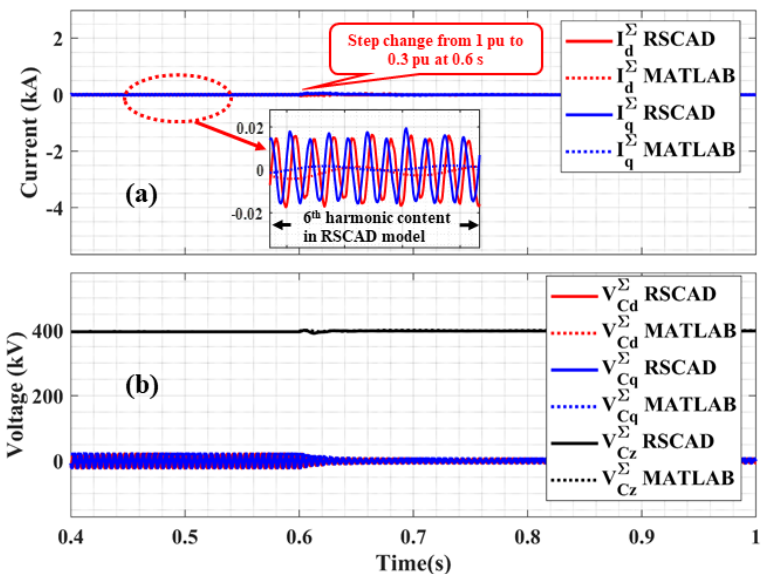
Figure 5. Comparison of: ( a ) active power; ( b ) reactive power; ( c ) output current i ∆ current i ∆ q ; in MATLAB (blue) and RSCAD (red) during step change of the active power from 1 p.u. to 0.3 p.u. at the time instance t = 0.6 s.